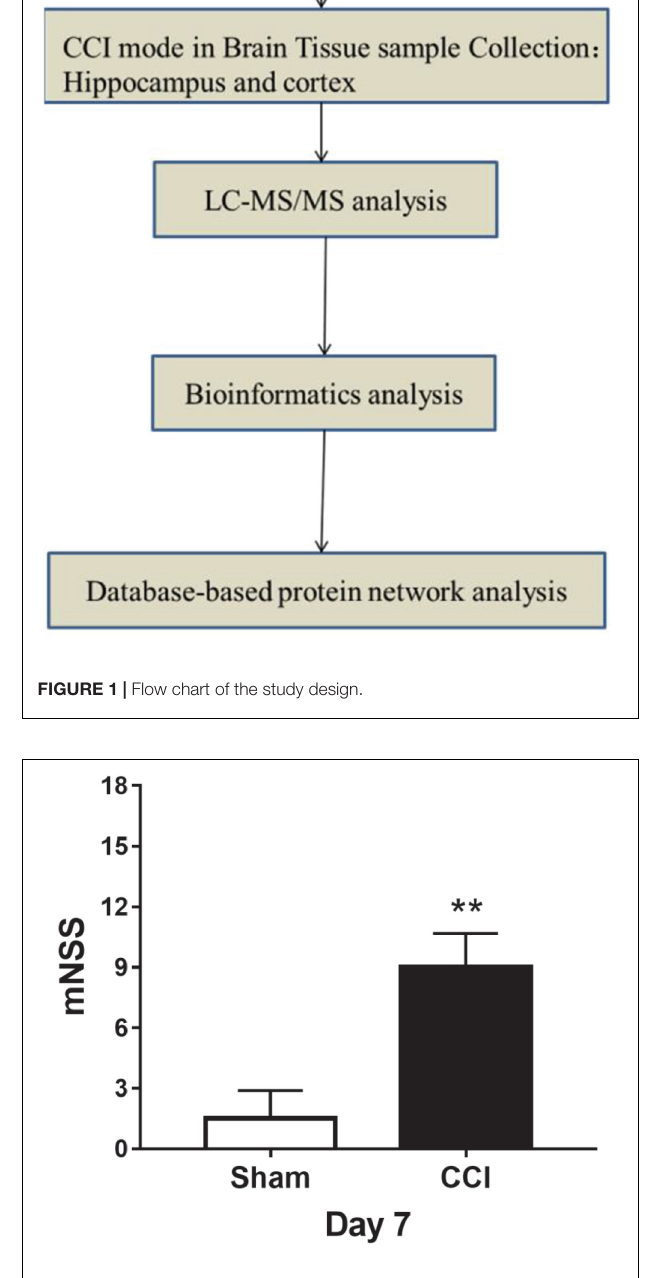
experiments were approved in compliance with the regulations of the Medical Ethics Committee at Xiangya Hospital Central South